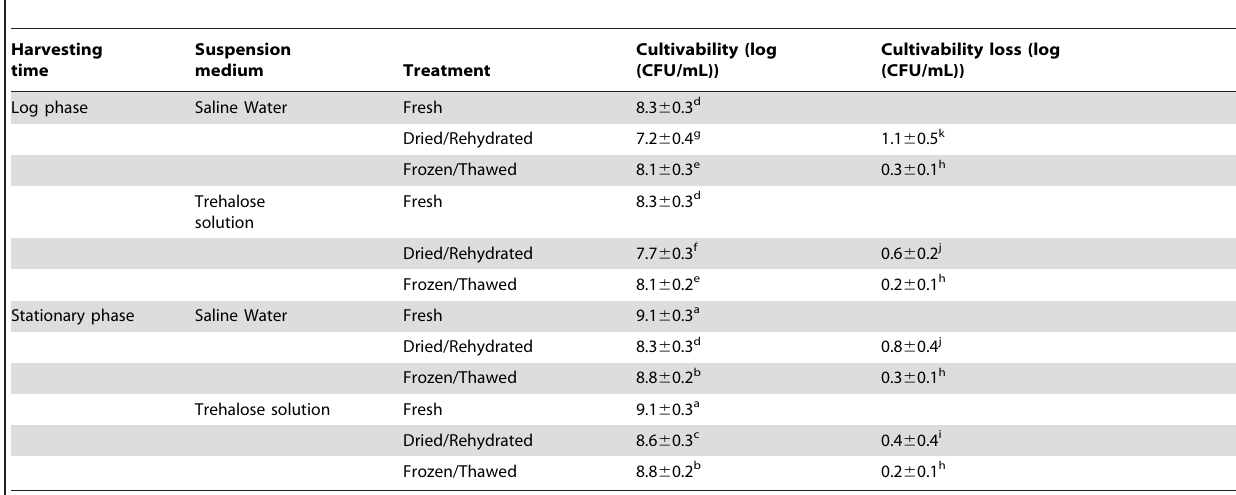
Table 1. Cell cultivability and cultivability loss (log (CFU/mL)) after drying/rehydration and freezing/thawing as a function of harvesting time (in the log or stationary phase), and use of protective medium (trehalose solution) or not (saline solution).